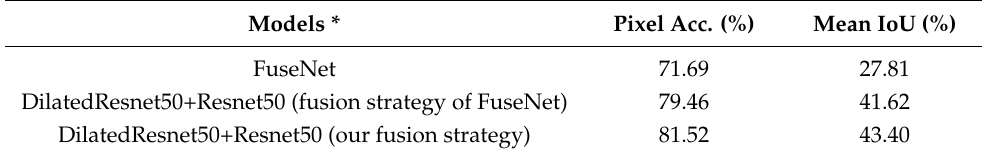
Table 3. Comparison of the fusion strategies of FuseNet [15] and